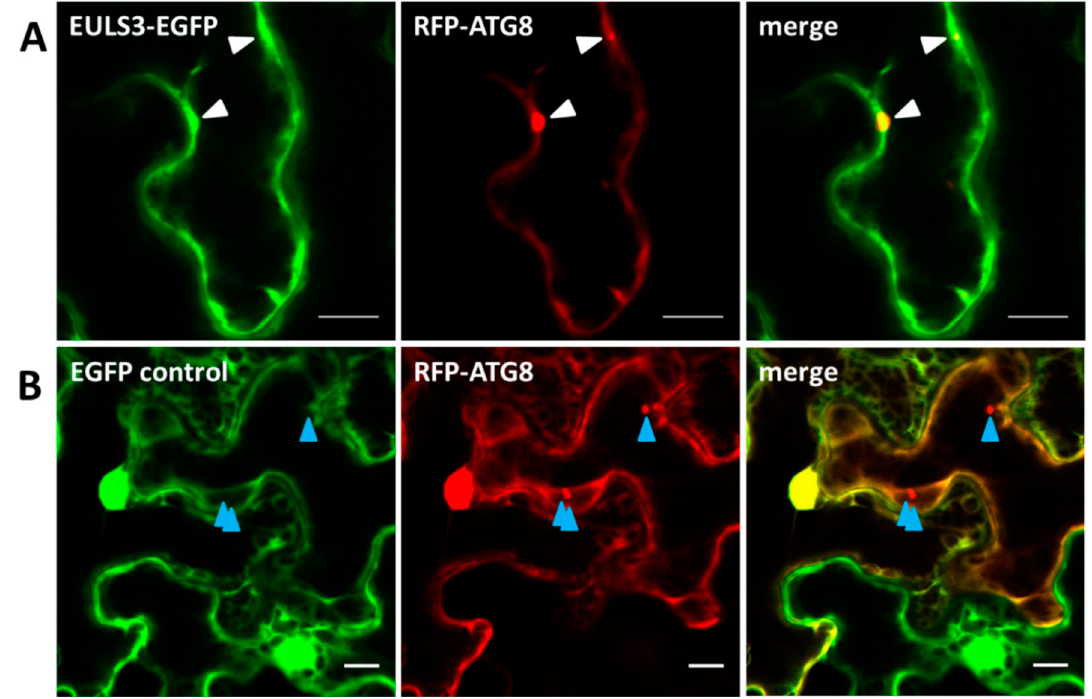
Figure 3. Colocalization of ArathEULS3-EGFP with RFP-ATG8 autophagy marker. ( A ) Transient coexpression of ArathEULS3-EGFP with RFP-ATG8 in N. benthamiana leaves at RT. ( B ) Control experiment showing transient coexpression of free-EGFP with RFP-ATG8 in N. benthamiana leaves. White triangles point to punctate structures where the GFP and RFP signals overlap and blue triangles indicate absence of colocalization. Scale bars represent 10 µm.